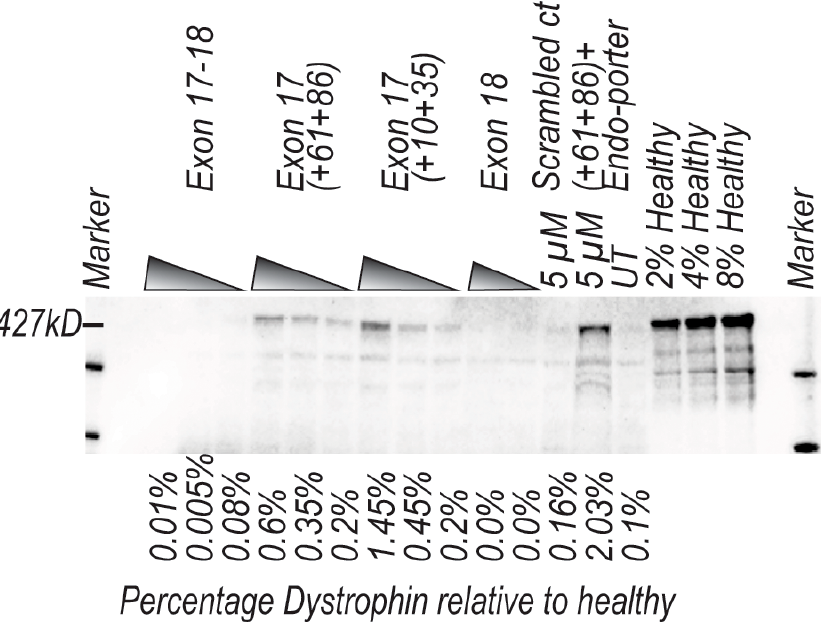
Figure 5. Western blotting analysis of AO-induced excision of dystrophin exons 17 and 18 from a dystrophic patient myogenic cell strain with a duplication of exons 14–17 after transfection with PMO and/or PPMO. Myogenic dystrophic cells were transfected with PMO and/or PPMO targeting exons 17 and 18 at 5 µM, 800 nM and 200 nM and incubated for 96 h. Protein was extracted, and western blotting was performed; western blot analysis showing the presence of DMD protein at 427kD. Protein loading was standardized according to myosin heavy chain densitometry performed on a Coomassie blue stained gradient gel. The quantity for each band was directly related to the healthy control.